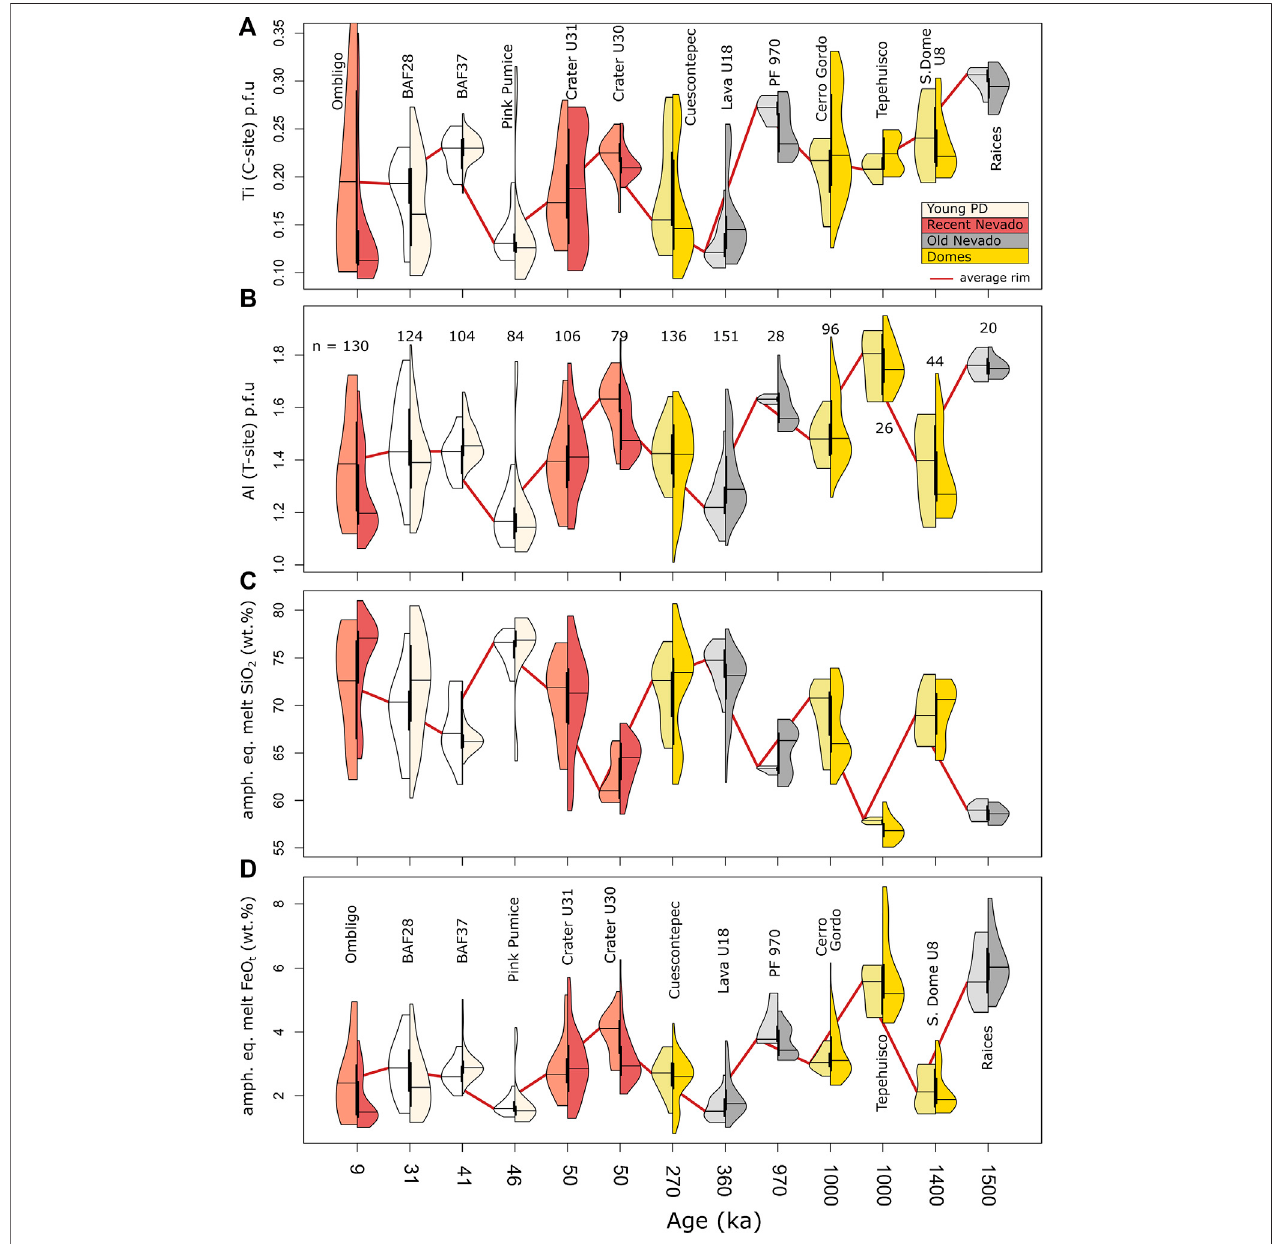
FIGURE12| Temporalvariationofamphibolecompositions (A,B) andamphiboleequilibriummelts (C,D) .Thecolorcodingre fl ectstheeruptivegroups:YoungPD (beige),RecentNevado(red),OldNevado(gray),Domes(gold). (A) DistributionsofTi(C-site)perforumulaunit(p.f.u)vs.timeforvariouseruptionsfromNevadodeToluca (labels). (B) Al on T-site p.f.u. plotted vs. time. (C) Amphibole equilibrium melt SiO 2 content (wt%). (D) FeO t contents (wt%) of melts in equilibrium with amphibole compositions. The melt compositions were estimated using equations 1 and 8 of Zhang et al.